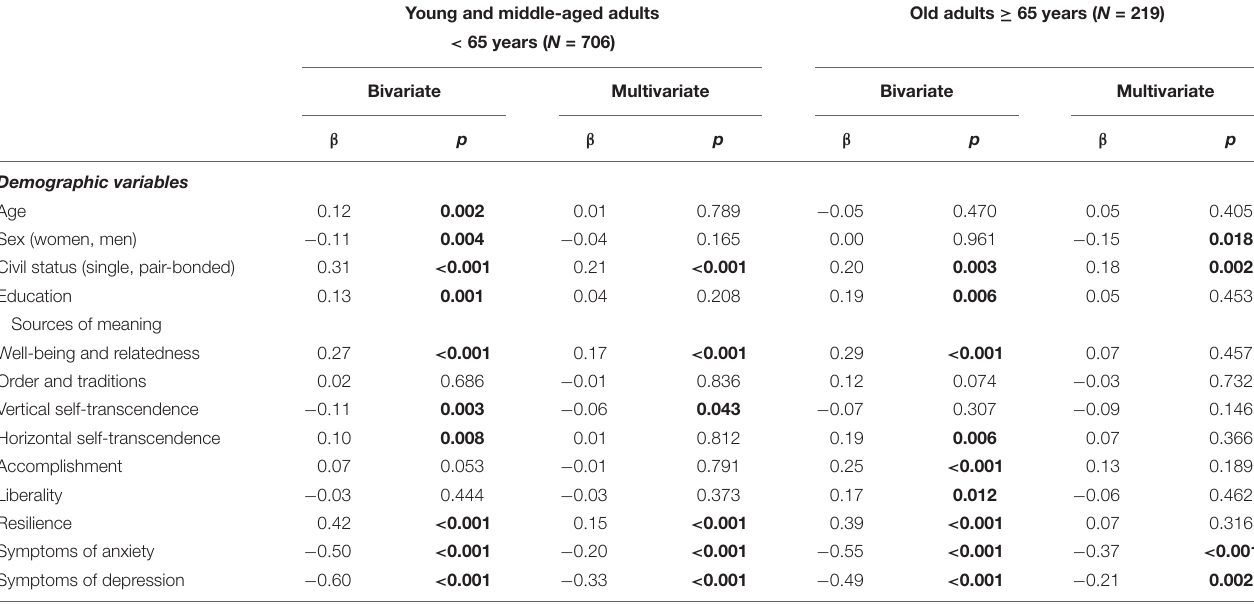
TABLE 3 | Bivariate and multivariate linear regression of the associations between demographics, anxiety, depression, sources of meaning, resilience, and satisfaction with life (dependent